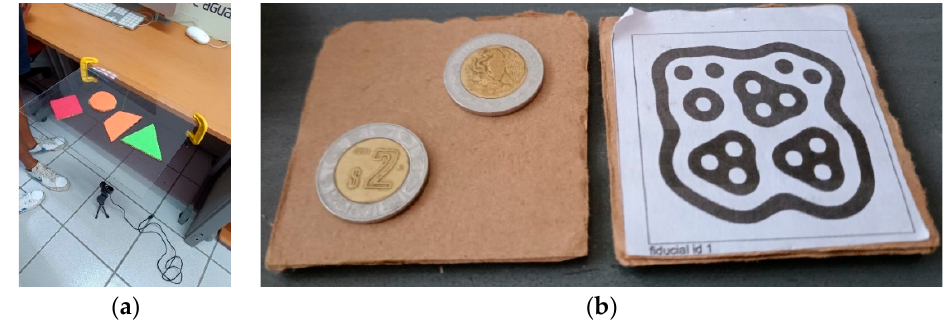
Figure 4. ( a ) Tangible interface built. ( b ) Tangible object with its fiducial marker.